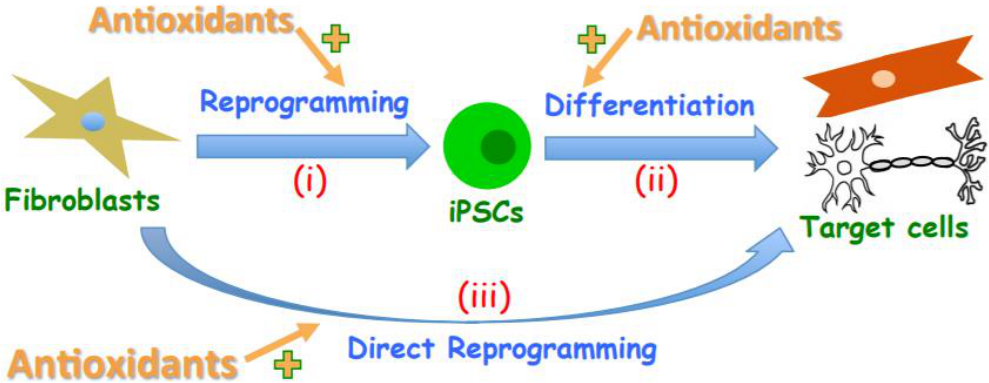
Figure 5. Schematics of the effects of antioxidants on cellular reprogramming. Antioxidants can improve (i) the conversion of fibroblasts into iPSCs, (ii) the differentiation of iPSCs into target cells, and (iii) the direct conversion of fibroblasts into target cells.